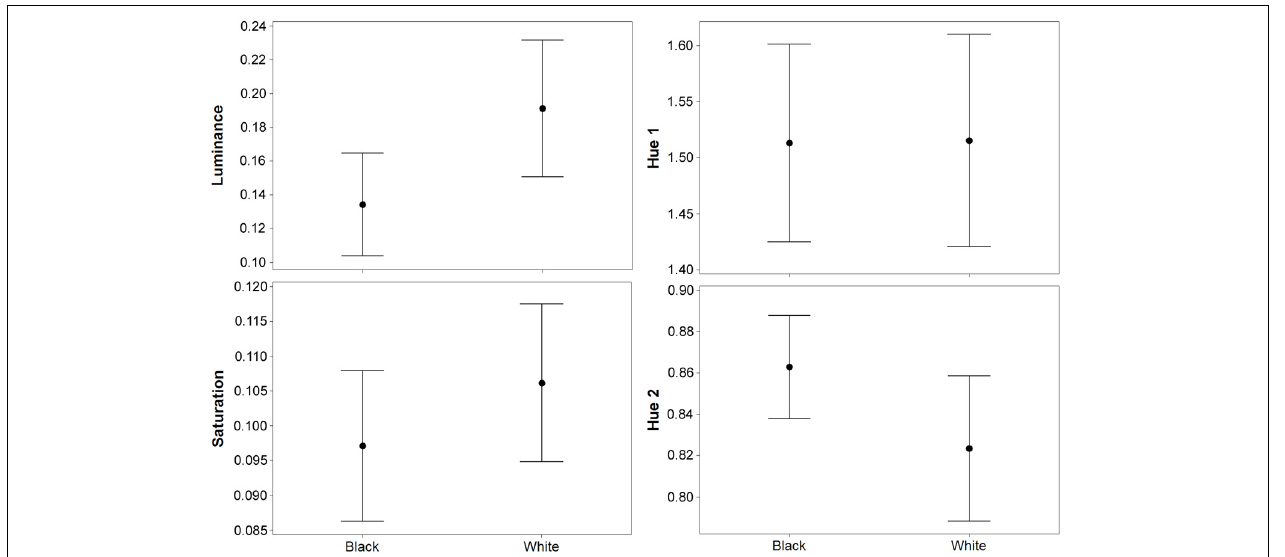
FIGURE 2 | Results (means plus standard error) from experiment 1 (black and white backgrounds) when analyzed with the avian visual model. Differences in luminance (perceived lightness), saturation, and hue 2 were